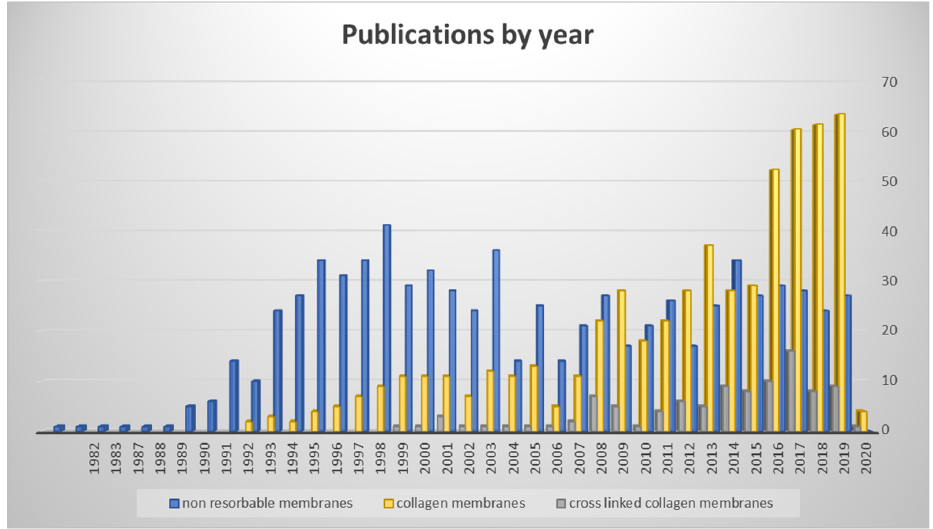
Figure 1. Publications by year on non-resorbable membranes, collagen membranes, and cross-linked membranes (data from PubMed Library). The chart clearly shows the increase of publications toward collagen membranes.